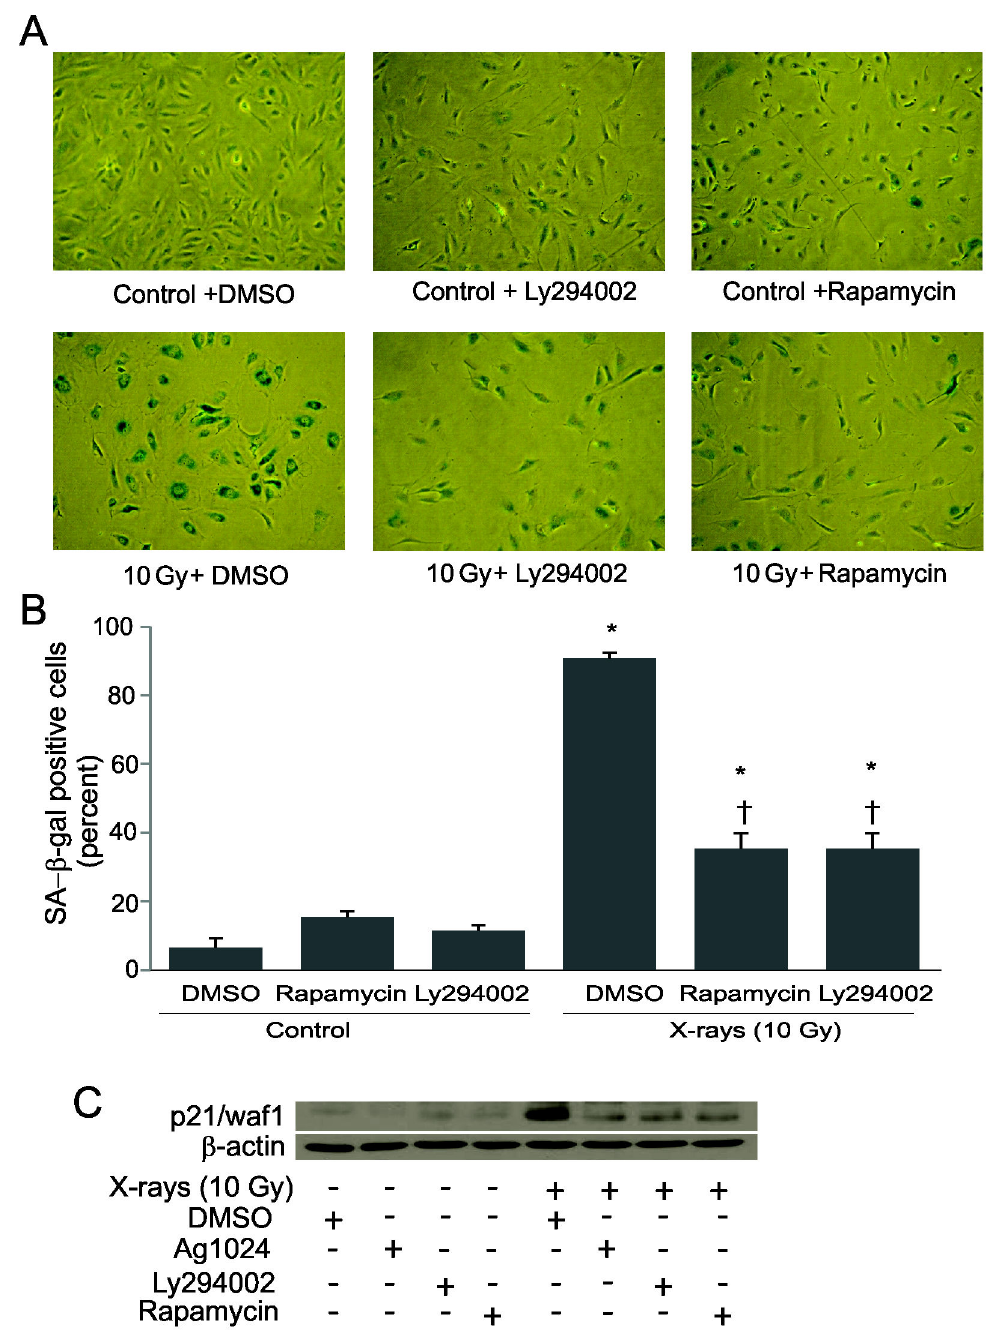
Figure 4. Attenuation of radiation-induced accelerated senescence by rapamycin and Ly294002. Subconfluent HPAEC were pretreated with 500 nM rapamycin, 20 μM Ly294002, or vehicle (DMSO) for 30 minutes, exposed to 10 Gy X-rays and then incubated until time of assay. (A) Representative pictures of SA-β-gal staining at 4 days post-irradiation (B) Percentage of SA-β-gal positive cells was counted in at least 3 random fields. Graph represents means ± SEM, n = 6. * indicates statistical significance from controls, p < 0.05. (C) Representative western blotting for p21/waf1 expression at indicated time-points post-irradiation in the presence of AG1024, rapamycin, Ly294002 or DMSO.